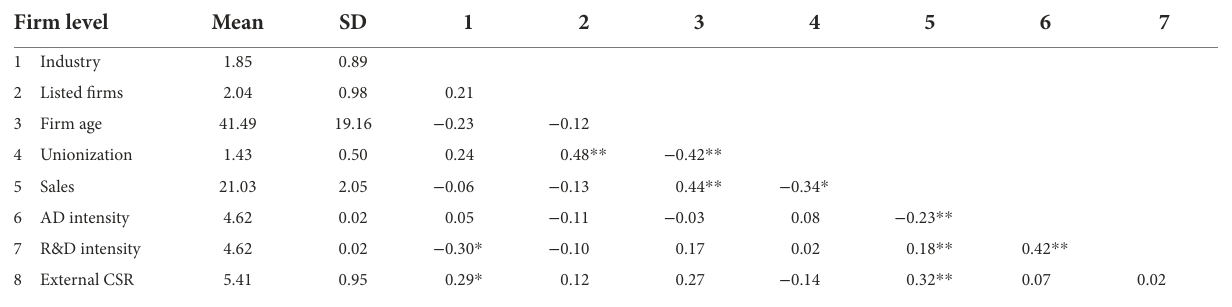
TABLE 4 Descriptive statistics and correlations among firm-level variables. Firm level